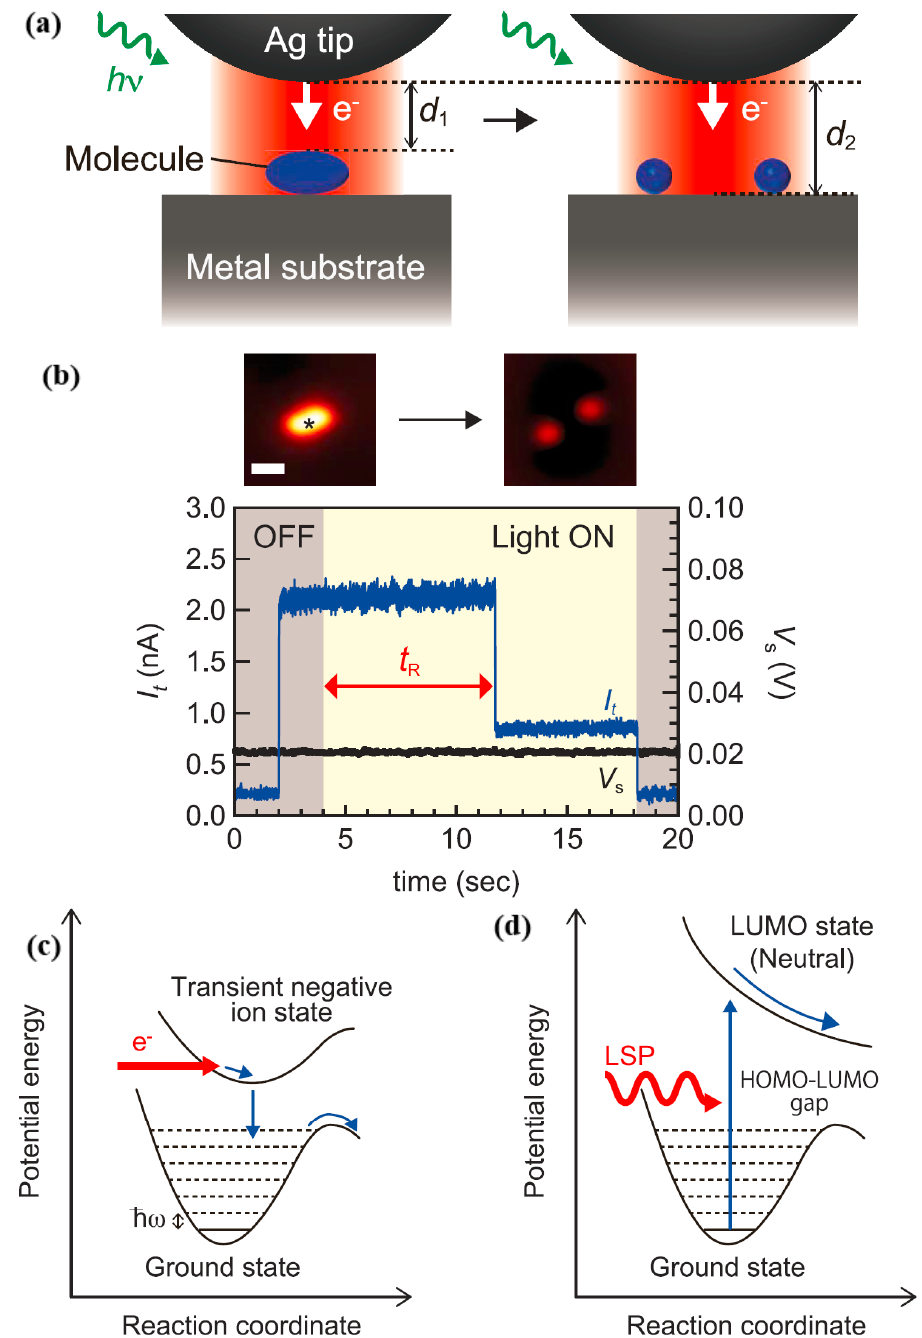
Figure 15. Real-time STM results for the plasmon-induced chemical reaction and transient negative state (IET)-induced reactions of a single molecule. ( a ) Schematic illustration of the real-time observation of the plasmon-induced chemical reaction. ( b ) Current trace for detecting the dissociation event for the target molecule (STM images) on Ag(111) induced by the LSP excited with p-polarized light at 532 nm (~2.7 × 10 15 photons cm − 2 s − 1 ). Schematic illustrations of the potential energy surface for the plasmon-induced chemical reactions on the basis of ( c ) the indirect hot-electron transfer mechanism and ( d ) the direct intramolecular excitation mechanism are shown. (cid:125) ω , Planck’s constant h divided by 2 π ( (cid:125) ) multiplied by the angular frequency ( ω ) . Adapted from